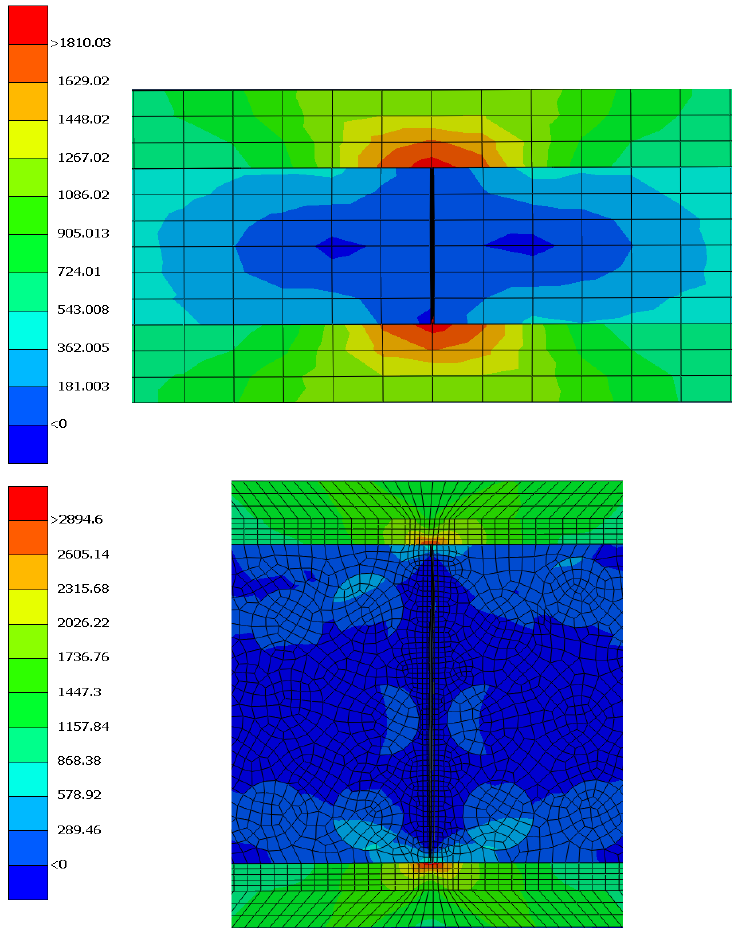
Figure 11. Stress concentration comparison between micro and macro